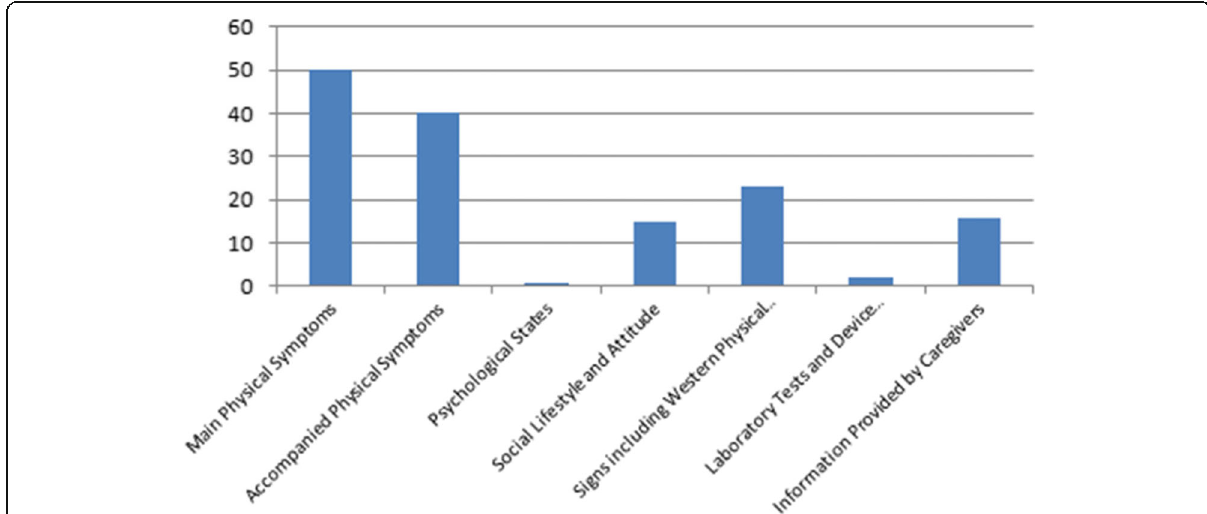
Fig. 3 Evaluation of Treatment Satisfaction Factors